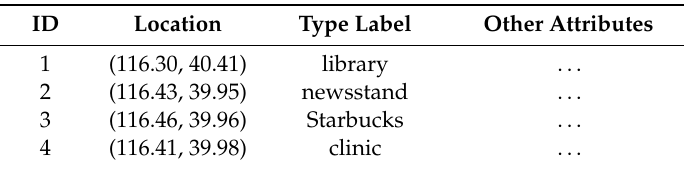
Table 1. Example of raw dataset